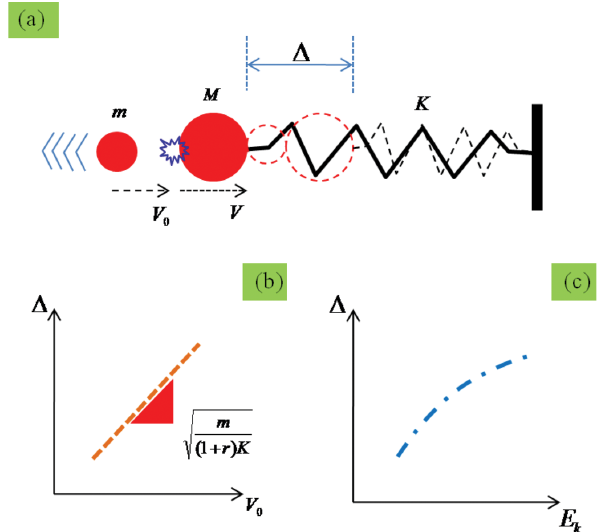
Fig. 9. Analytical modelling and formulation. (a) : a simple lumped mass SDOF analytical model proposed for LPR structure. (b) : the formulated linear relation between the structural displacement and the velocity of the block; the slope of the line is also shown. (c) : the nonlinear (quadratic) relation between the structural displacement and the incident kinetic energy of the